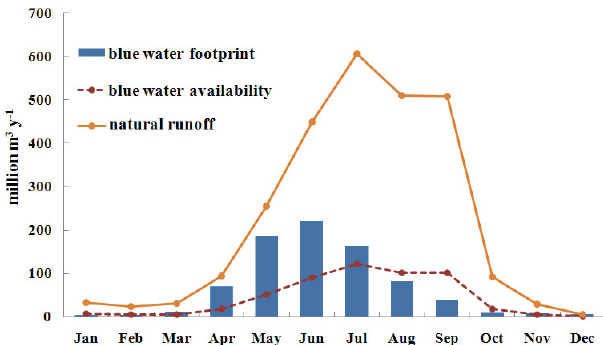
Fig. 8. Comparison between average monthly blue water footprint and blue water availability in the HRB over